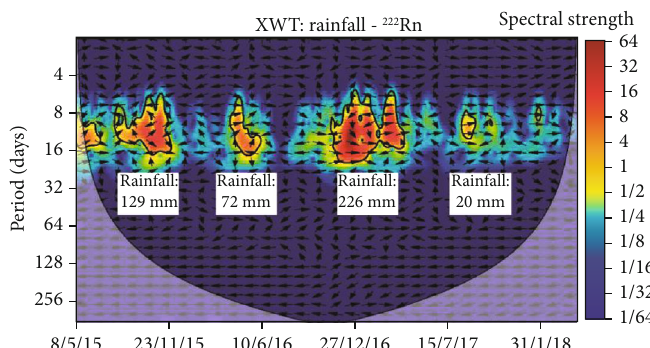
Figure 10: XWT between rainfall and 222 Rn at high frequencies; spectral strength ranges from blue (weak) to red (strong) colors. Curved lines on the scalograms indicate the cone of in fl uence where the edge e ff ects are important.